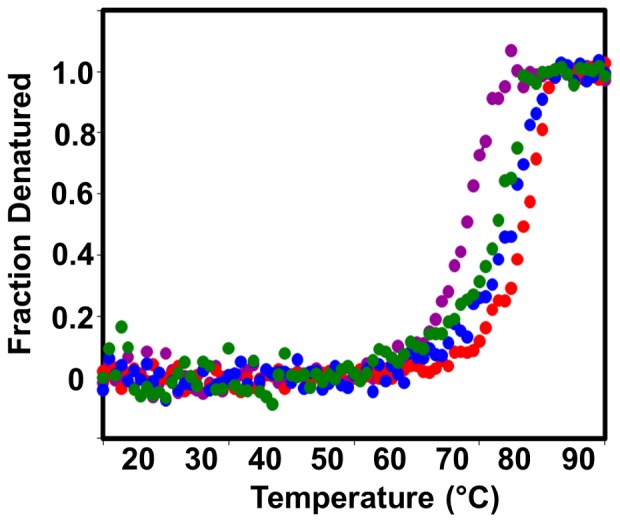
Thermal stability of complexes.Thermal denaturation curves of ternary complexes formed by the interaction of Cdk2/cyclin A and p27-KIDwt (red), p27-KID+H (blue), p27-KID−H (green), or p27-KIDloop (purple).